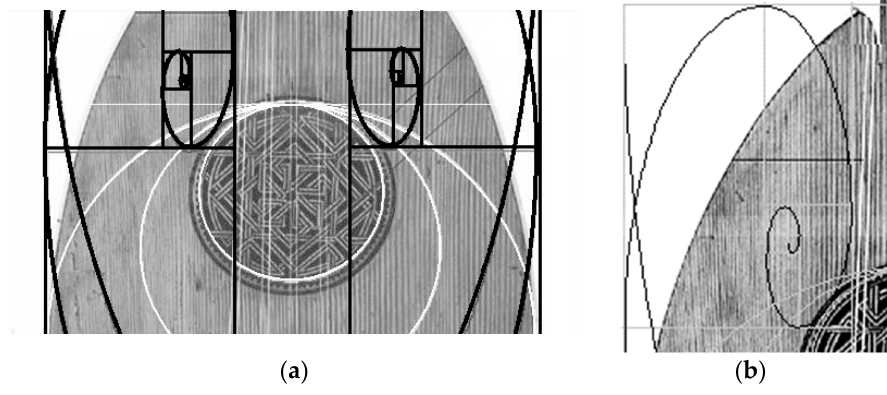
Figure 5. ( a ) Step seven: check the situation, ( b ) the optimized size and location of the sound ‐ hole.